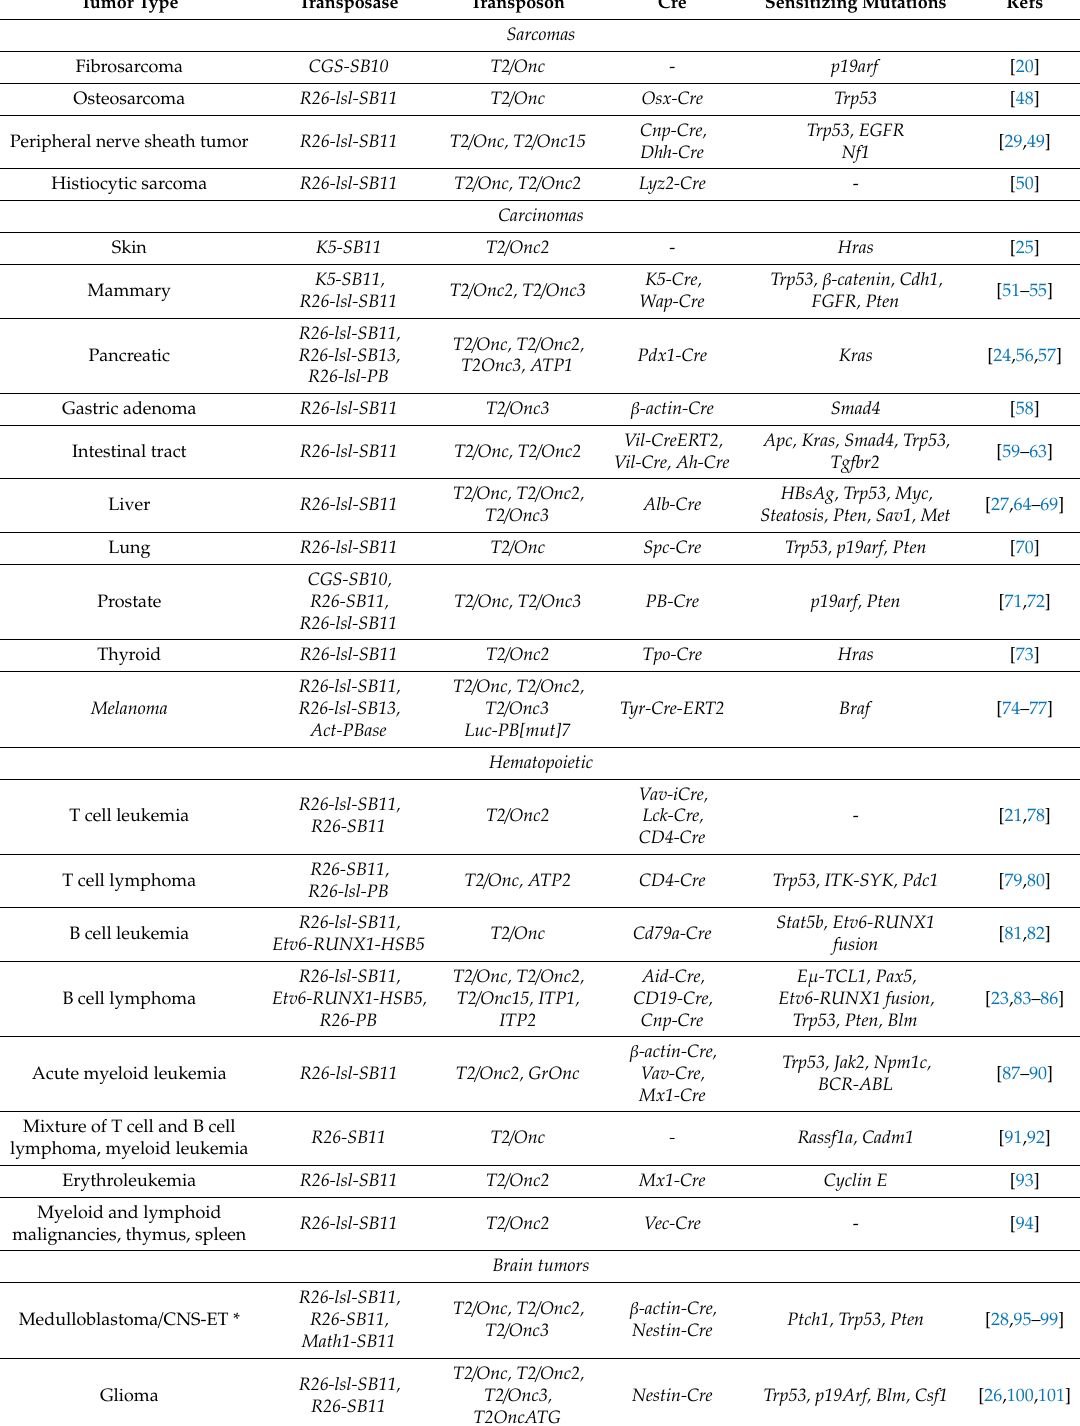
Table 2. Published Sleeping Beauty and piggyBac Cancer Screens in